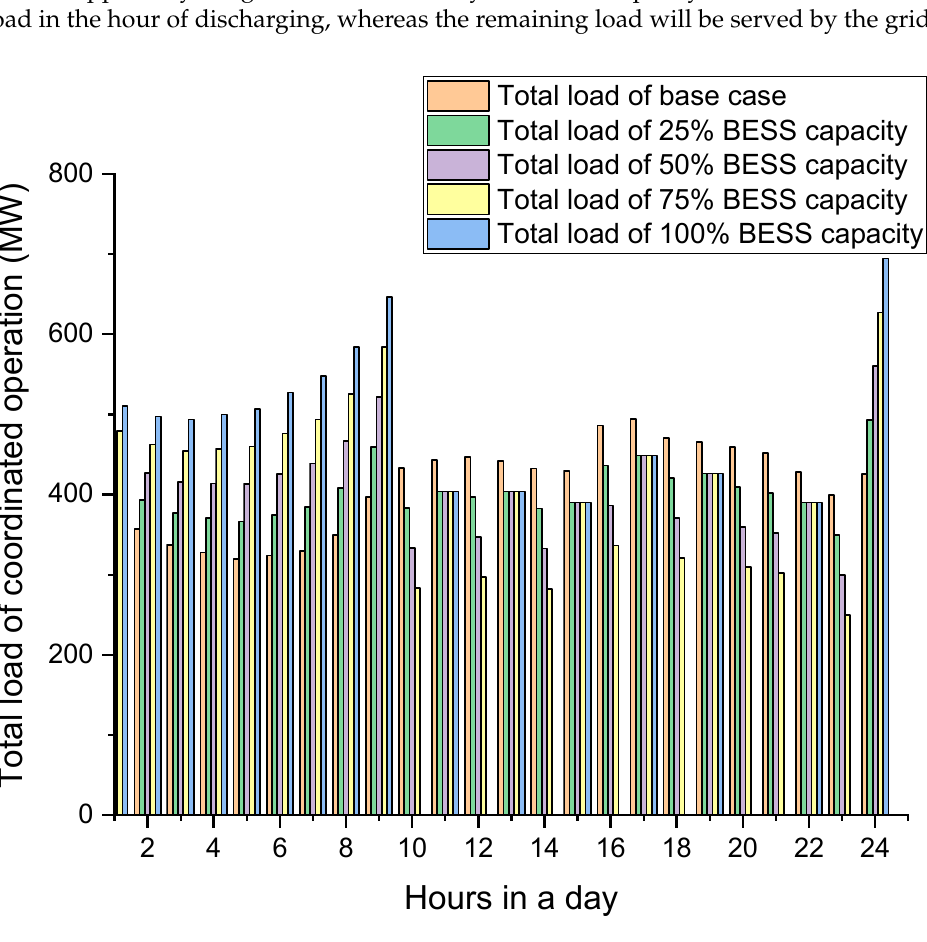
Figure 3. Total load due to Coordinated Methodology.